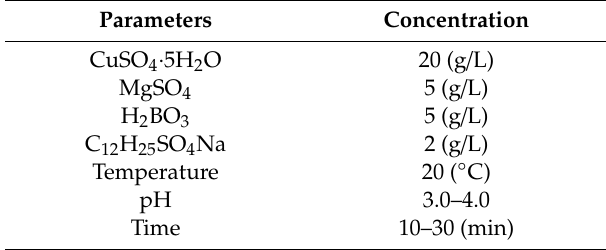
Table 2. Composition of electroplating bath and